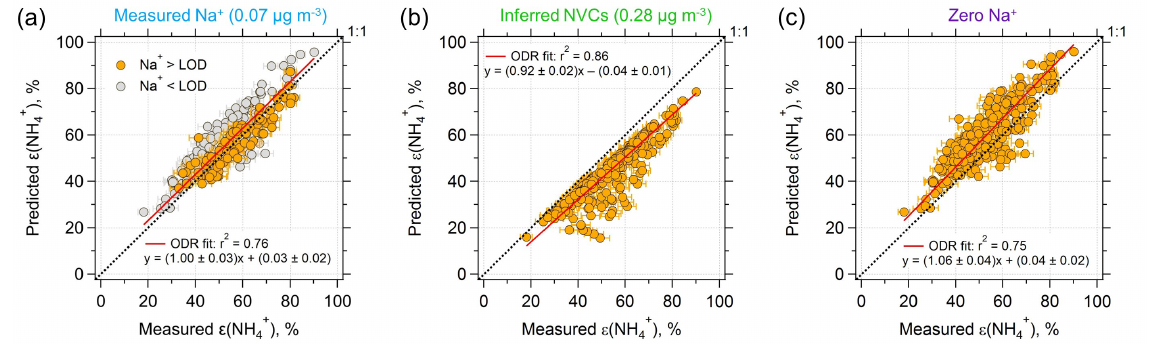
/ NH x . (a) The model ) = NH + 4 4 , NO − , and Cl − . (b) Same model input, but NVCs (represented 4 3 ) 4 (20%) and NH 3 (6.8%) measurements. The best agreement is achieved by using measured Na + 4